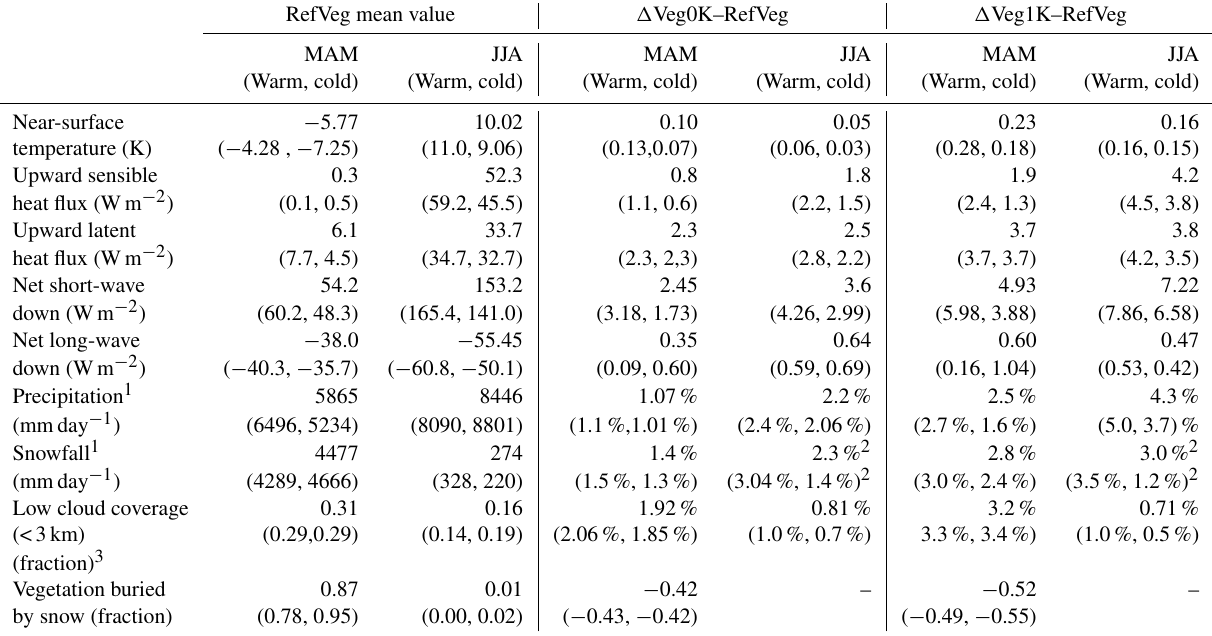
Table 1. Mean response in surface fluxes and near-surface atmospheric variables as averaged over all areas with vegetation